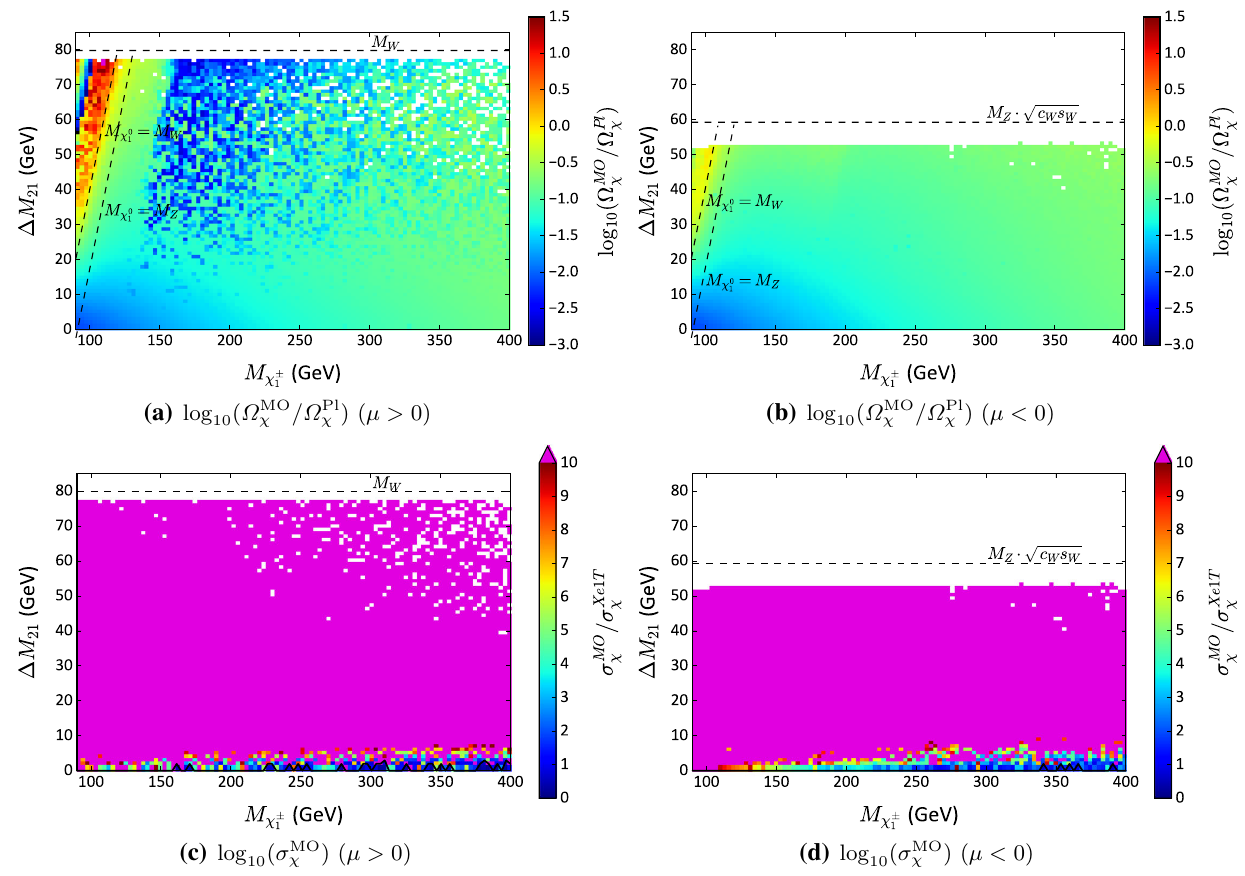
Fig. 7 Upper figures: logarithmic ratio of predicted and observed relic abundance of light higgsino dark matter for μ > 0 ( a ) and μ < 0 ( b ). Lower figures: ratios of predicted cross sections and Xenon1T exclu-